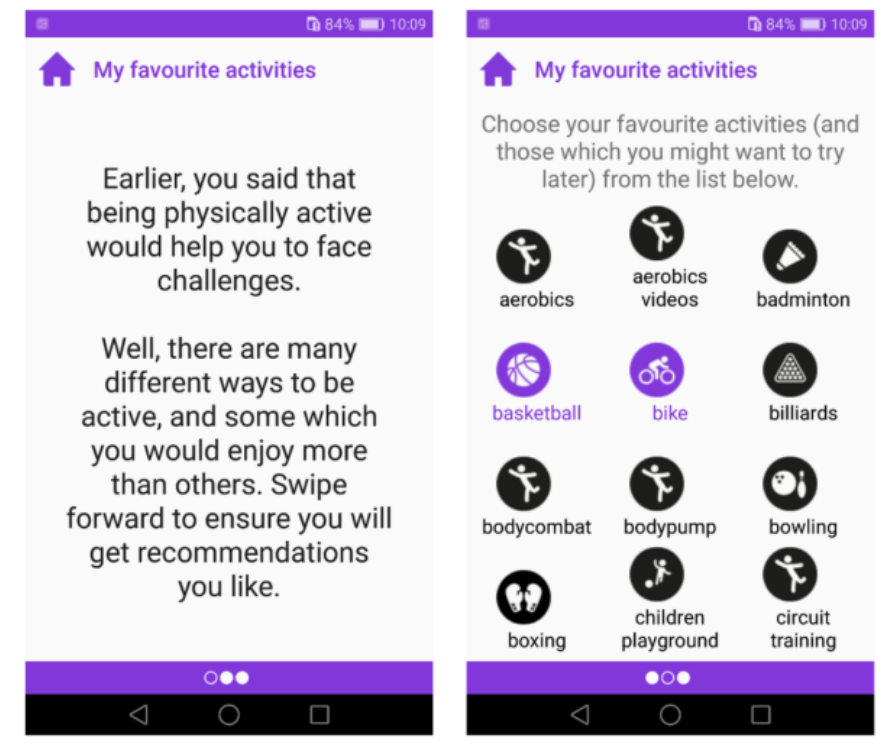
Figure 6. Implementation of the My Favorites tool, in which users choose the modes of PA that they might like to undertake. The prompt on Screen A recalls the outcome goal the user set in the What do I want?